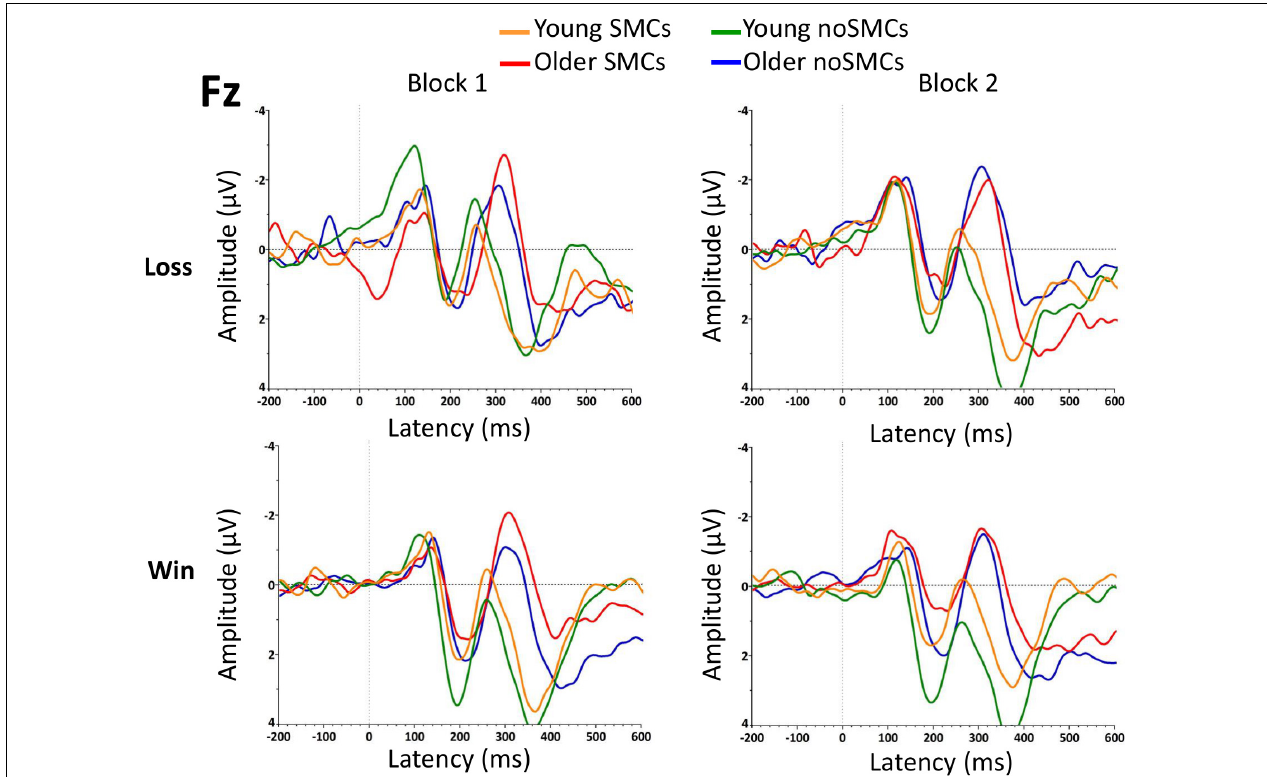
FIGURE 3 | Grand averages of the feedback-related negativity (FRN) component at the Fz electrode for the two